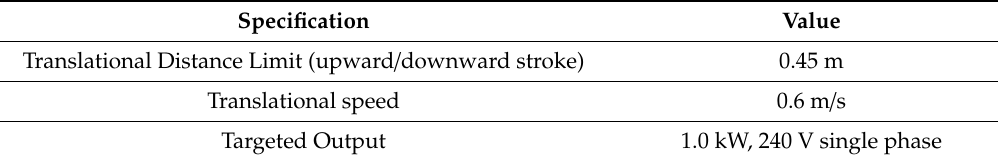
Table 2. Specification of the